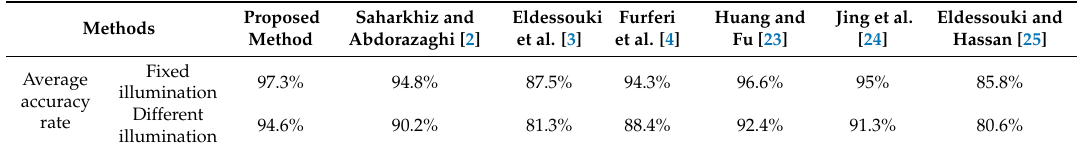
Table 3. Comparison of results using various